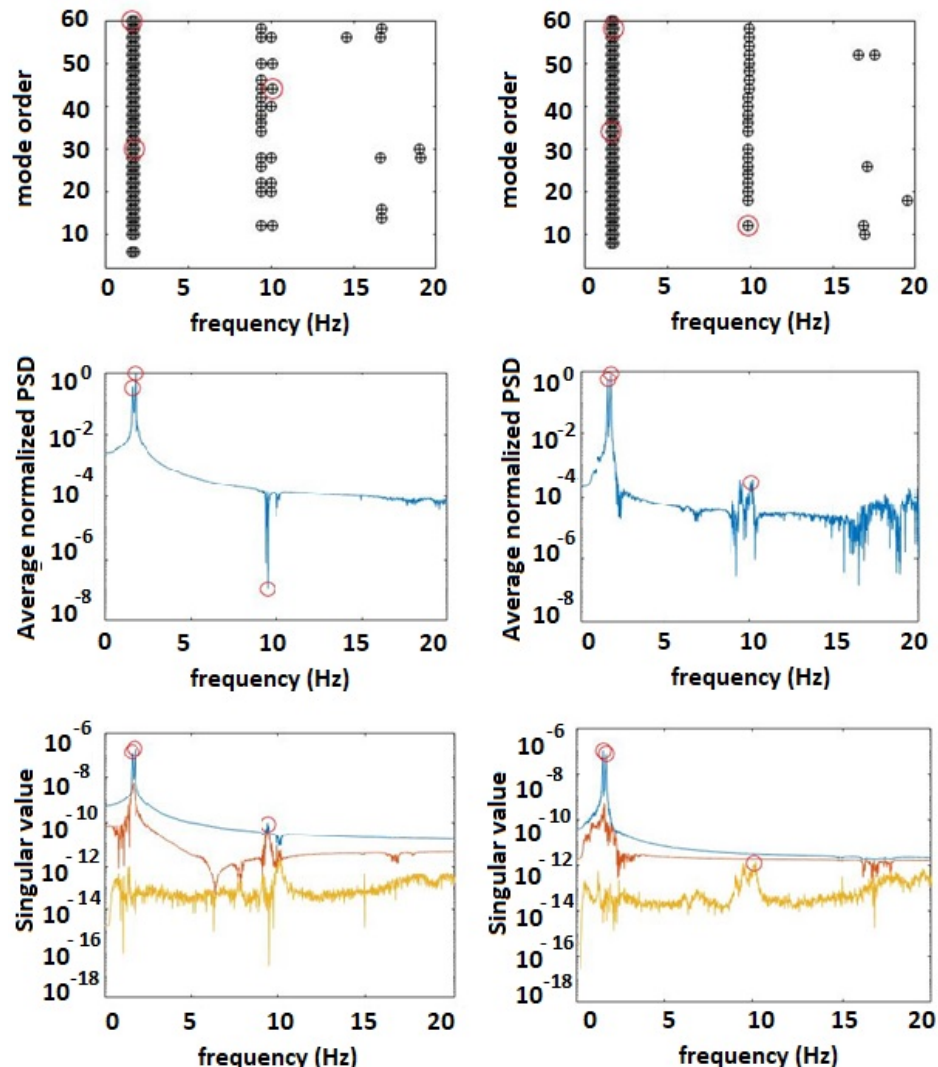
Figure 8. Identification results through OMA for the minaret based on the SSI ( top ), PP ( middle ), and FDD ( bottom ) methods.